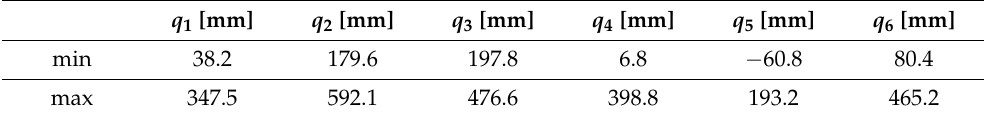
Table 2. Active joints ranges for the design